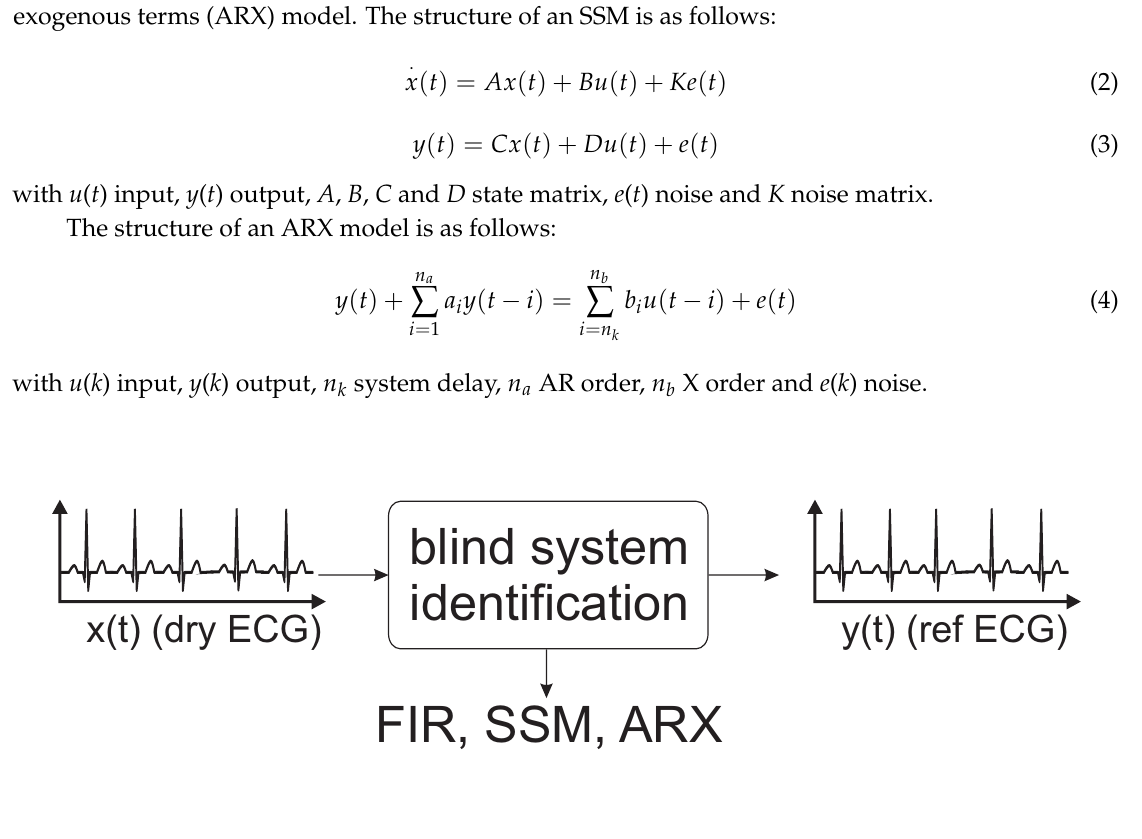
Figure 4. System identification phase for uECG: Blind system identification with models (finite impulse response (FIR), state space model (SSM) and autoregressive with exogenous terms